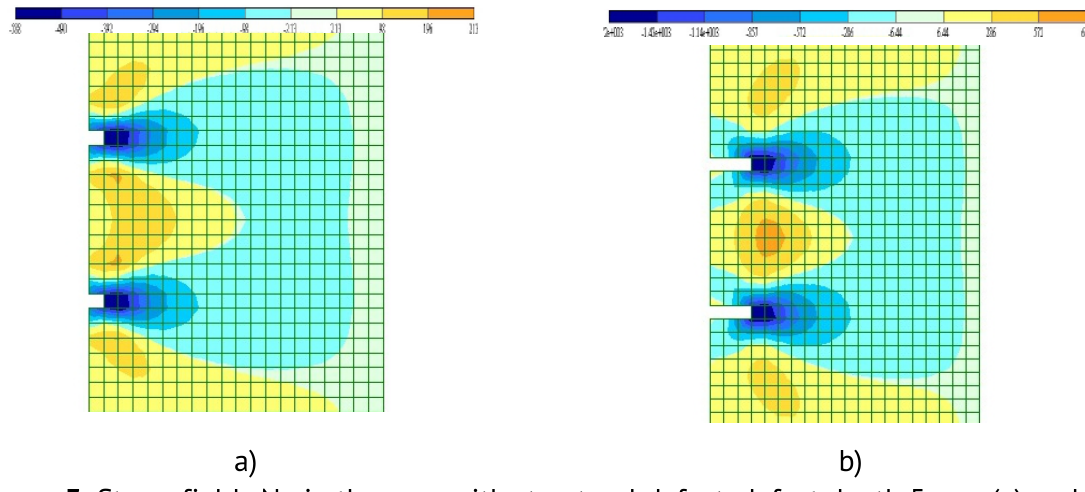
Figure 3. Stress fields Nx in the area with structural defect: defect depth 5 mm (а) and 15 mm (b) for concrete grade С20/25 under stress in concrete